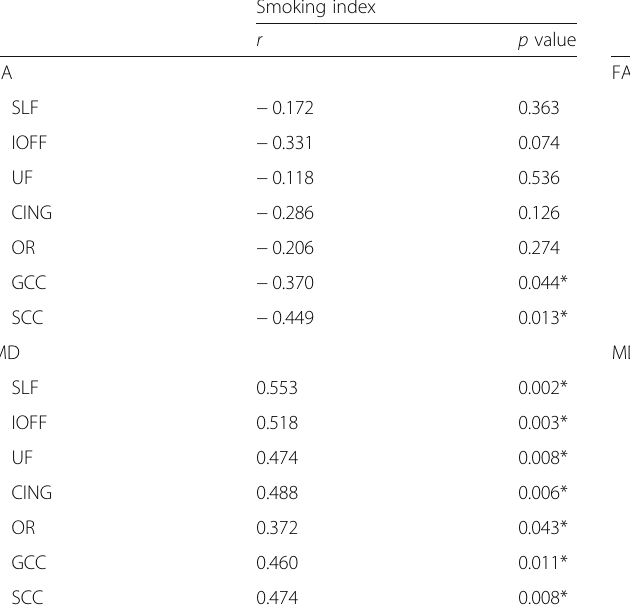
Table 4 The Correlation between number of exacerbations